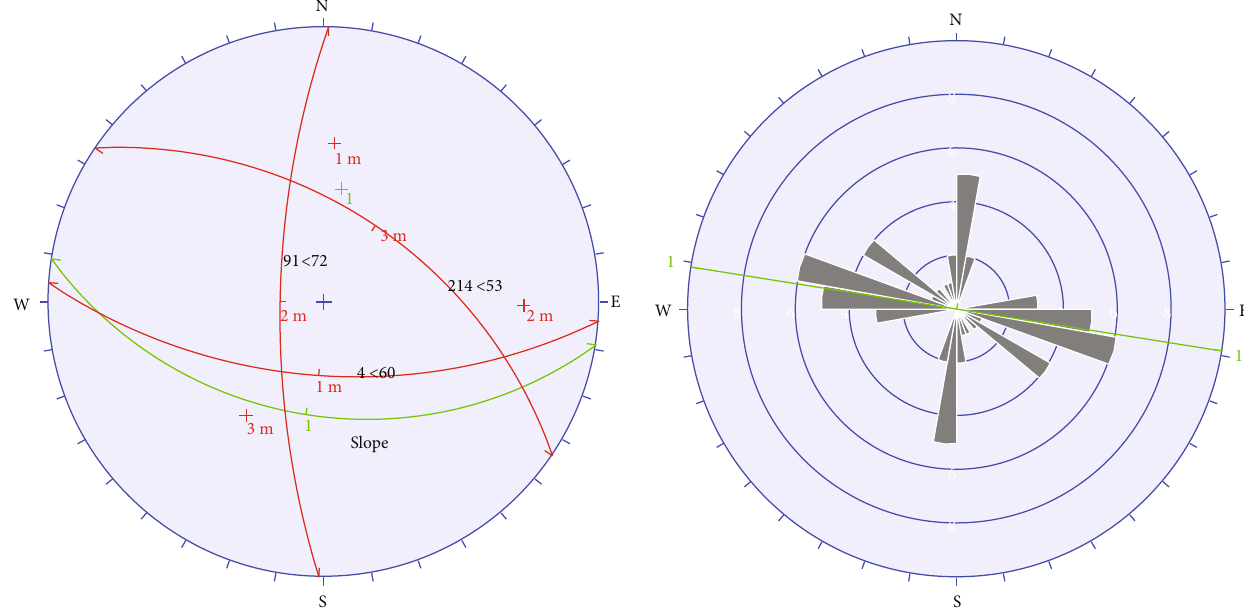
Figure 2: No. 1 observation point stereographic projection and joint rose map.